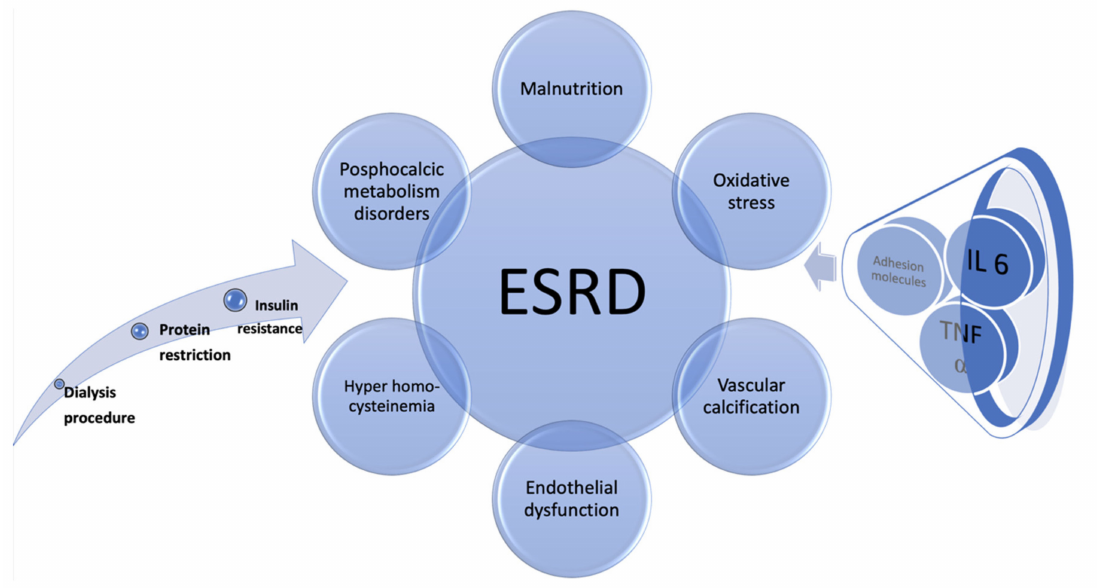
Figure 4. Pathophysiology of the accelerated atherosclerosis process in patients with